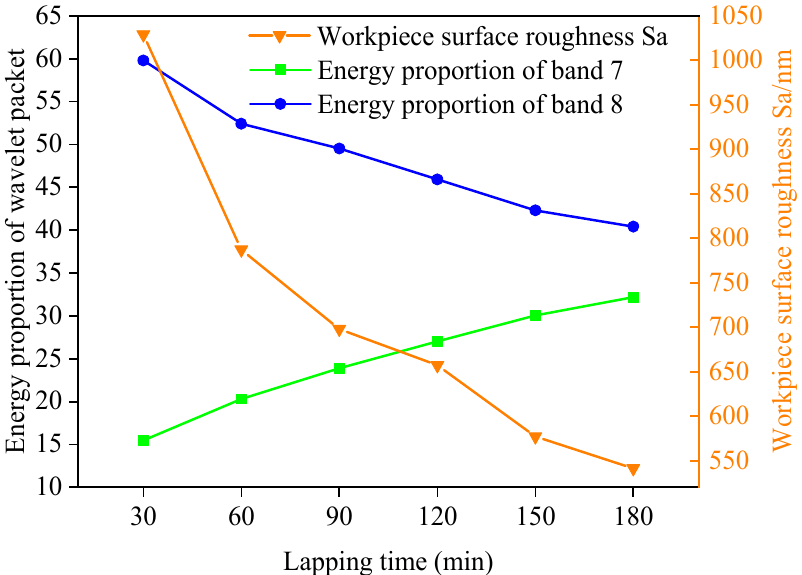
Figure 10. Relationship between workpiece surface roughness and energy proportion of frequency bands 7 and 8.